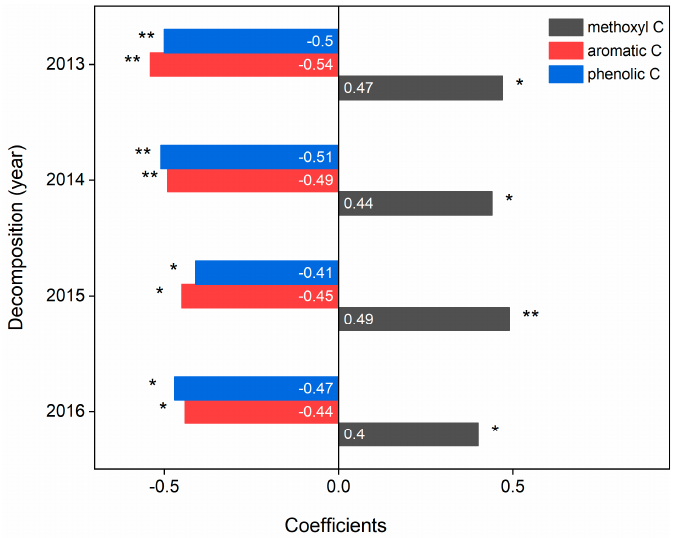
Figure 4. Results of linear regression analysis between functional C groups and C loss in litter decomposition processes. The * indicates the significance ( p < 0.05) between functional C groups and C loss at different decomposition stages in the regression model. * p < 0.05, ** p < 0.01, and Pearson’s r values from linear regression are shown in each panel.